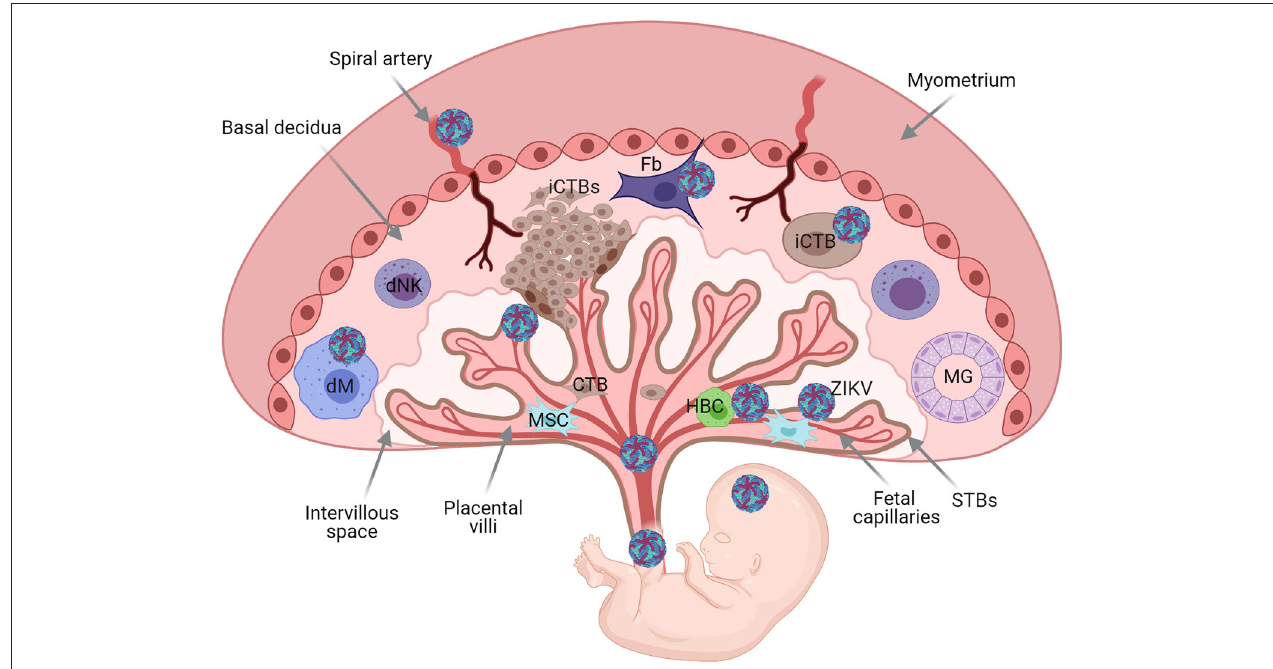
FIGURE 2 | Schematic representation of the human maternal-fetal interface and fetus, and transmission of pathogens. Basal decidua containing decidual Natural Killer cells (dNK), maternal macrophages (dM ϕ ), and stroma cells [mesenchymal (Ms) and fibroblasts (Fb)]. Maternal gland (MG). Extravillous invasive cytotrophoblast cells (iCTBs) invade the maternal decidua. Trophoblast Villous core contains trophoblast cells, mesynchymal cells, Hoffbauer cells (HBC), and fetal capillaries protected with an outermost layer of multinucleacted syncytiotrophoblast cells (STBs). Placental chorionic villi floating bathed by maternal blood within the intervillous space. Viruses can reach the fetus through hematogenous spread or through the basal decidua. Illustration of Zika virus (ZIKV), as model. ZIKV can replicate in the decidua and placental cells before dissemination to the